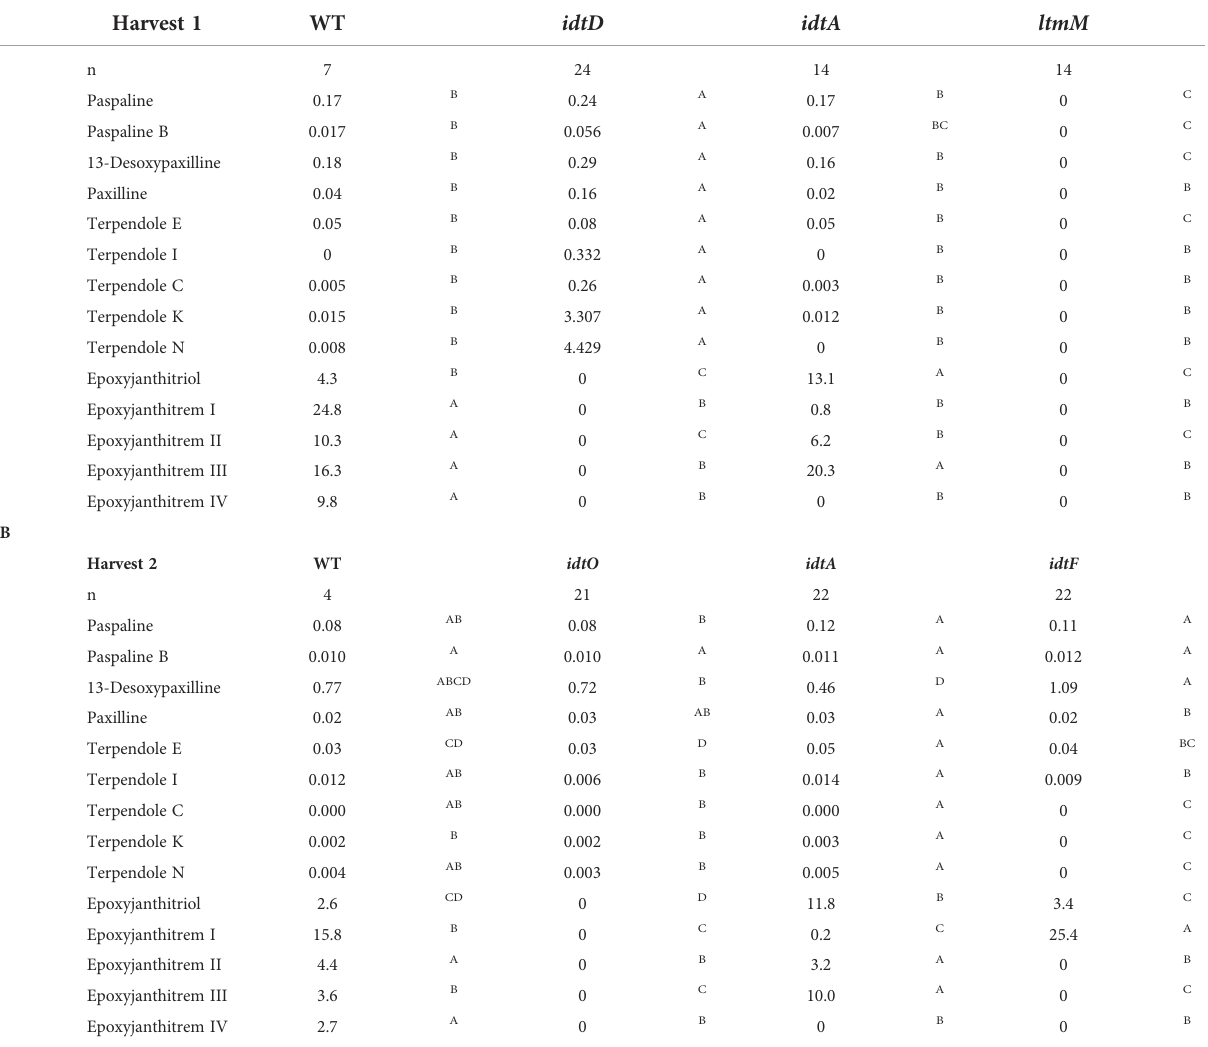
TABLE 2 Levels of indole diterpenes in AR37 wild type (WT) and AR37 strains with biosynthetic genes inactivated through CRISPR gene